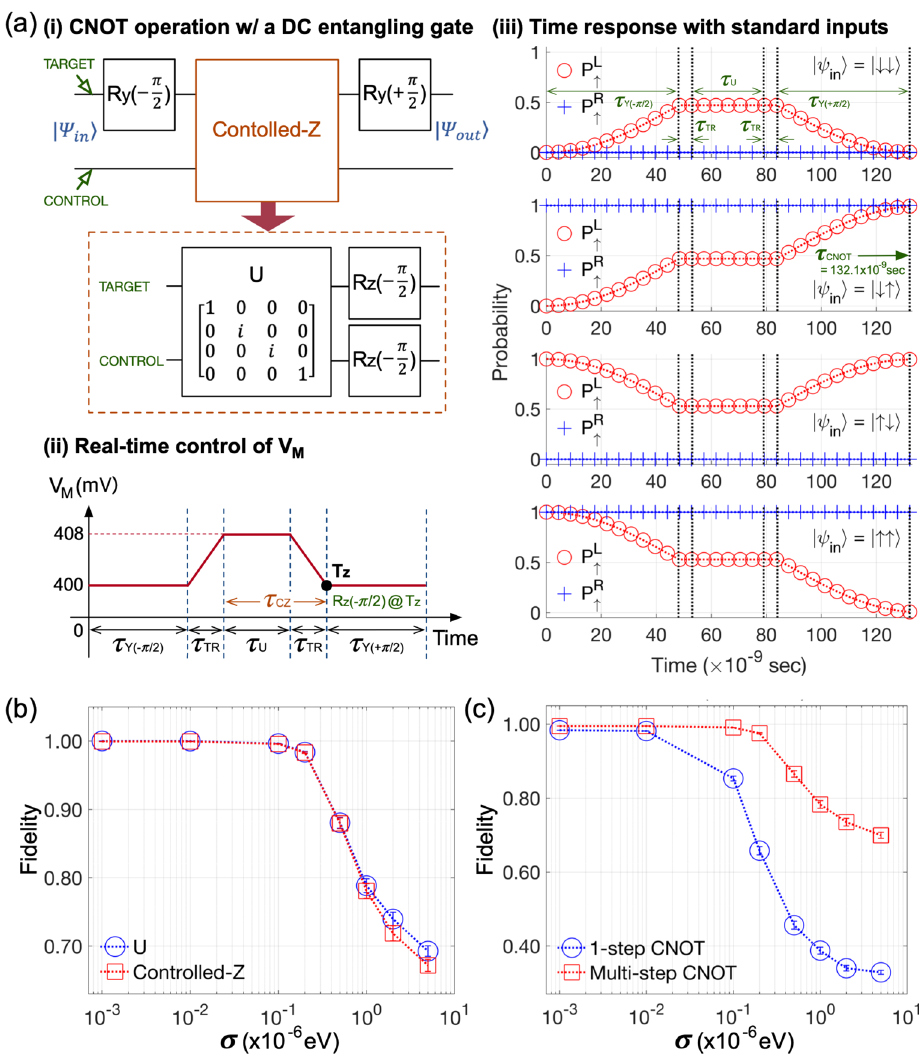
Figure 5. Multi-step CNOT operation with DC entangling logic. ( a ) (i) The CNOT operation can be achieved with three steps, where the second one (a controlled-Z (CZ) gate) consists of a 2-qubit unitary U and two 1-qubit rotation blocks ( R Z ( − π/ 2 ) ) that can be implemented with only DC biases in double quantum dot (DQD) platforms. Here the entanglement is generated by U . (ii) A real-time control of the middle gate bias ( V M ) for the three-step CNOT operation when the left and right gate bias are 540 mV and 570 mV, respectively. A bias-transition time ( τ TR ) of 5 nanoseconds (ns) is assumed. (iii) Resulting 2-qubit time responses show that the CNOT operation is completed at 132.1 ns. ( b ) The fidelity of a U and a CZ block are shown as a function of the magnitude of charge noise, indicating that 1-qubit Z-rotations do not quite affect the preciseness of the overall CZ operation. ( c ) The multi-step CNOT operation is much more robust to charge noise than the single-step case, mainly due to the noise-robustness of the DC entangling block U